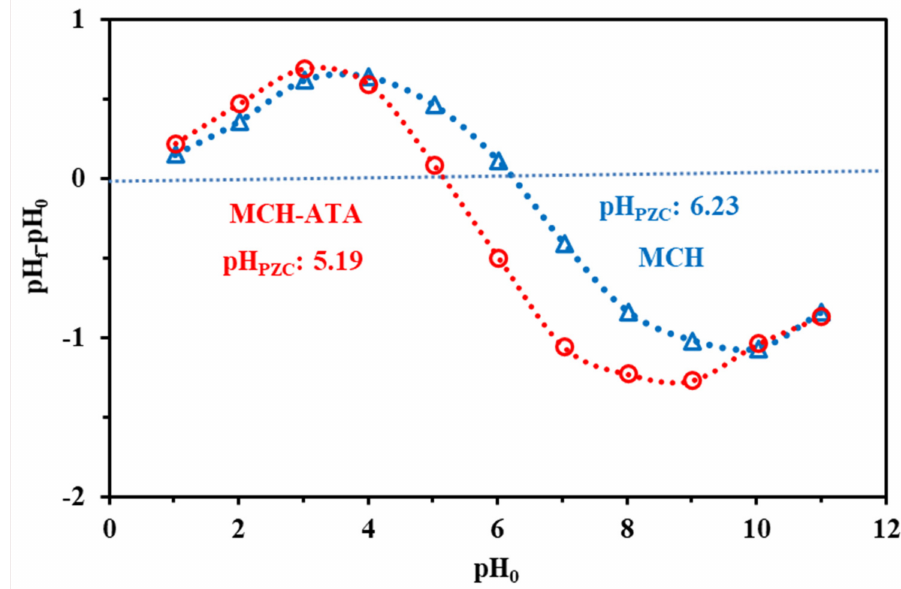
Figure 5. pH pzc profiles of MCH and MCH-ATA using pH-drift